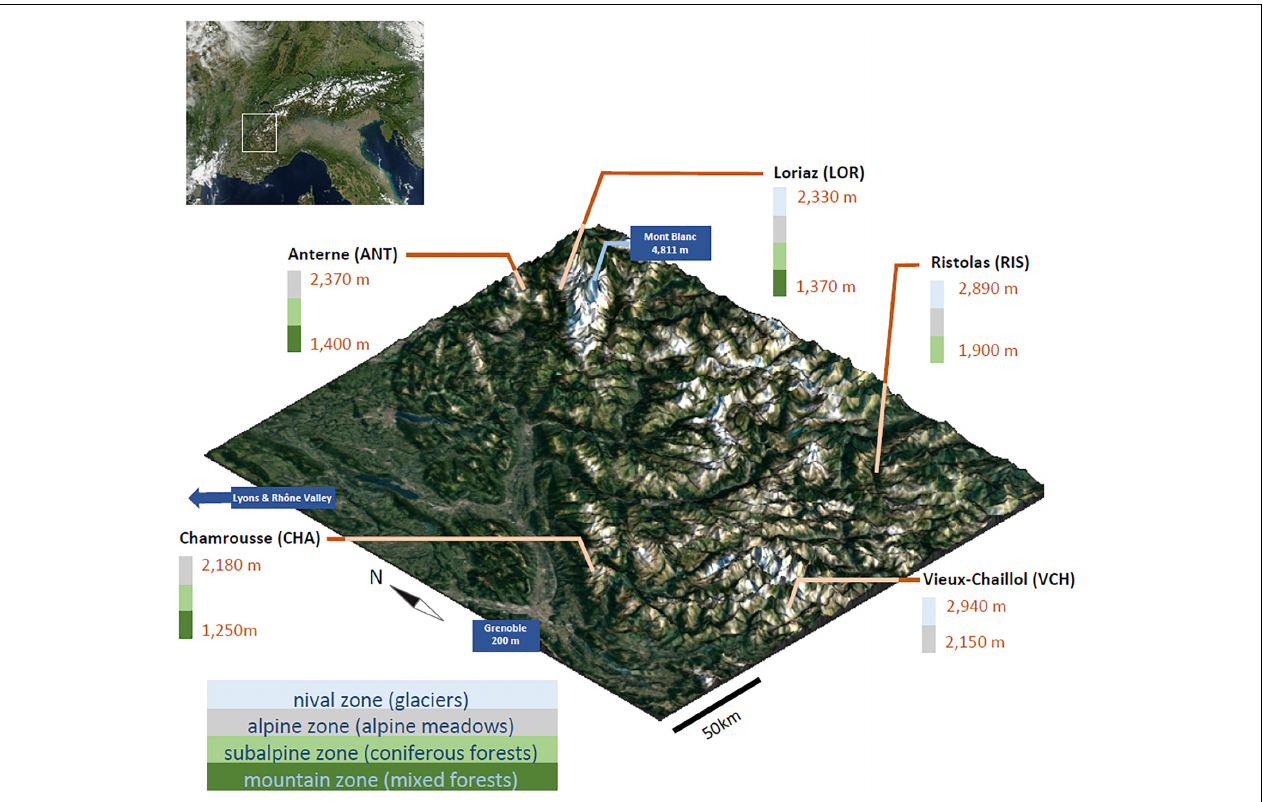
FIGURE 1 | Aerial view of the five sampled elevational gradients and their topography (1,250–2,940 m). Selected sites cover the full range of environments and habitats found in the Alpine altitudinal zonation and a representative geographical distribution. DNA was extracted from soil collected at each sampling location and used for an evaluation of Chlorophyta communities by DNA metabarcoding. Satellite images from